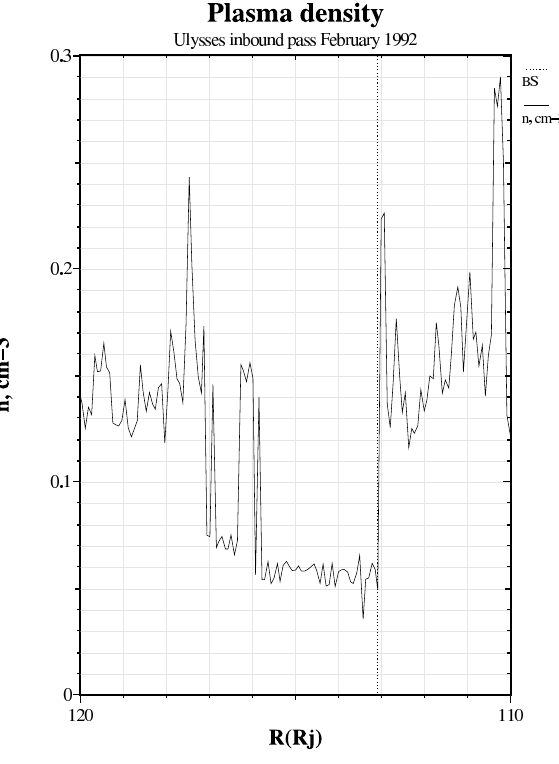
Fig. 10. Measured by SWOOPS plasma velocity in the course of the bow shock crossing by Ulysses during the first Jupiter flyby, February 1992. The bow shock position is marked by a dashed vertical line. Data (SWOOPS, PI J. L. Phillips LANL, USA) are received by using the COHOWEB system, NSSDC, NASA/GSFC, USA; ftp://nssdcftp.gsfc.nasa.gov/spacecraft data/